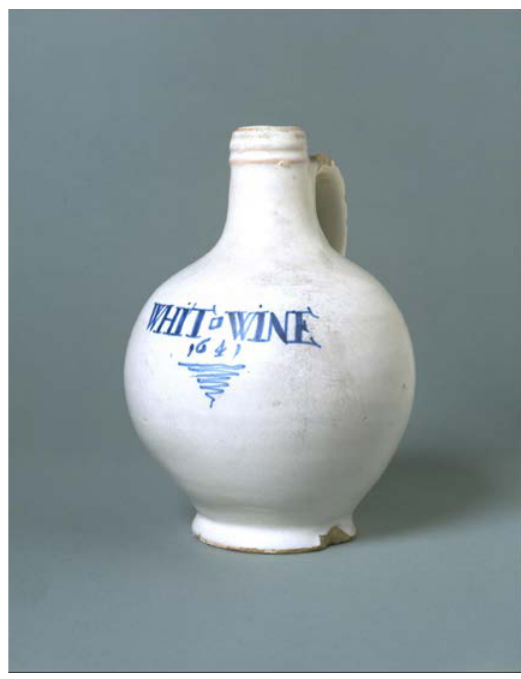
Figure 2 – Victoria and Albert Museum, London, museum no.